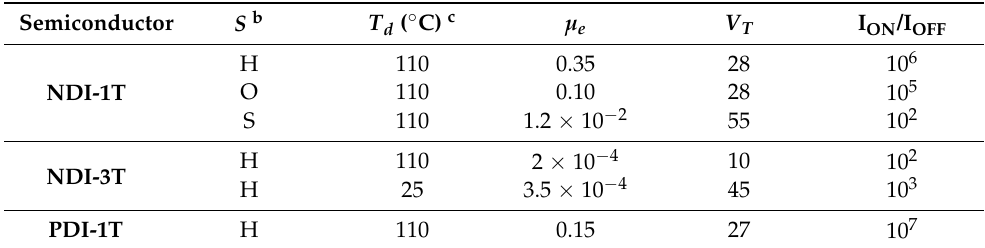
Table 2. OTFT Electrical data for vapor-deposited films of NDI-1T , NDI-3T , PDI-1T , PDI-3T and NDI-T-Ph-T measured under vacuum on Si/SiO 2 substrates a